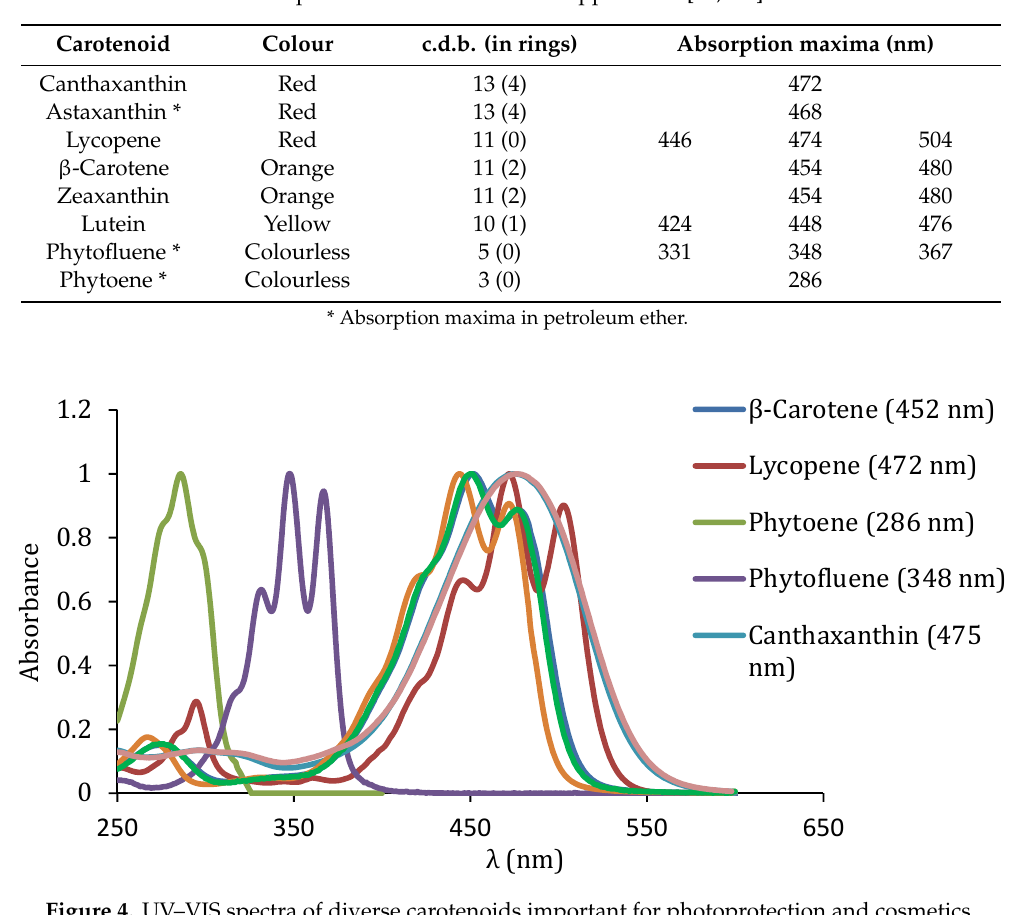
Table 2. Absorption maxima in acetone or petroleum ether, number of conjugated double bonds (c.d.b.) and colour of carotenoids important for skin health and appearance [99,100].